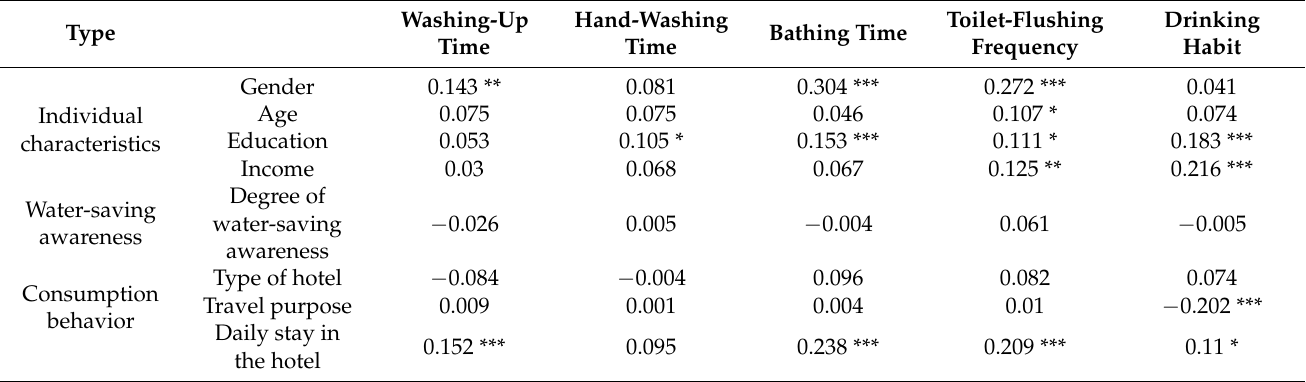
Table 3. Identification of influencing single factors of hotel consumers’ water-use